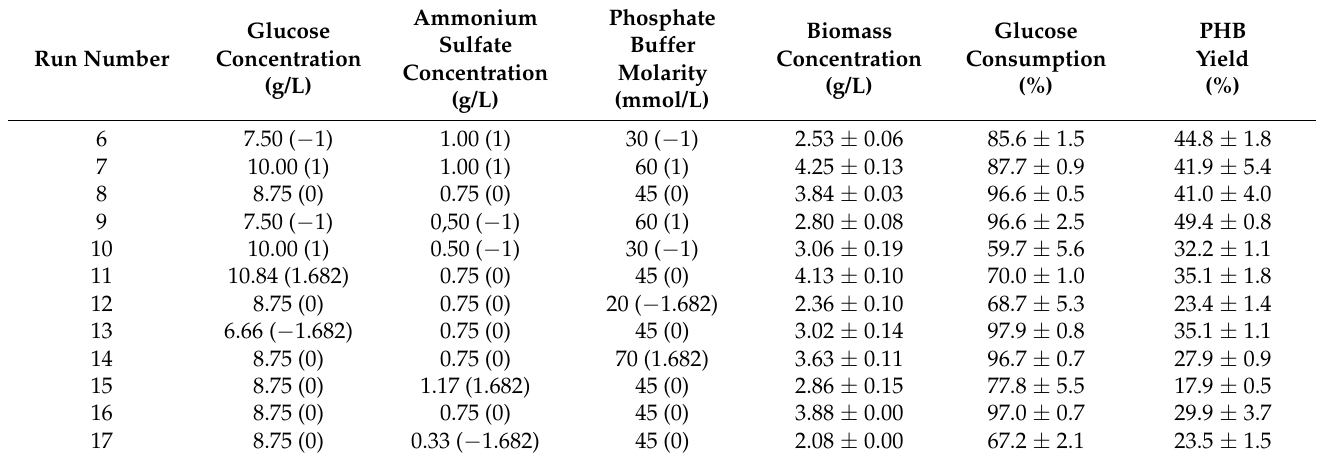
Table 3. Regression coefficients of the hypothesized second-order polynomial model for the de- pendent variables.